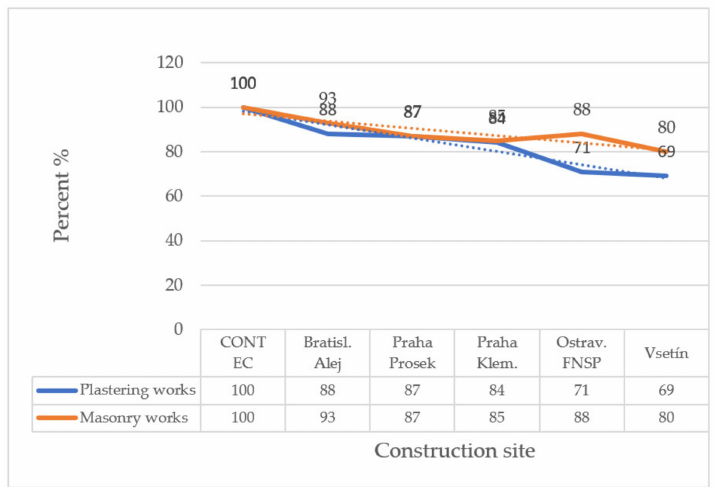
Figure 20. Percentual fulfillment of the construction